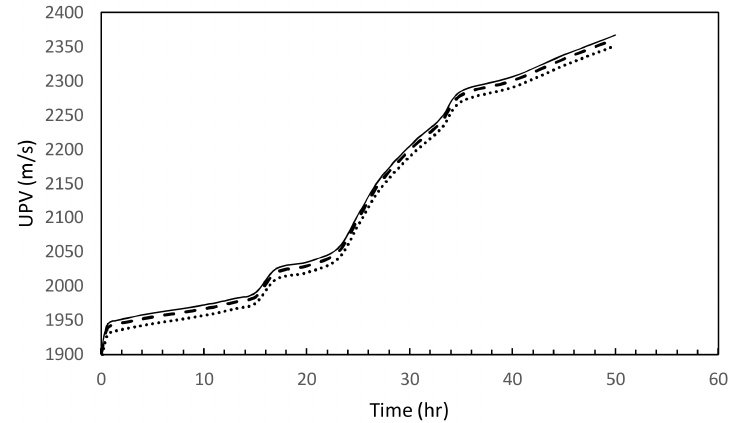
Figure 16. Reproducibility check on three UPV tests for the same mix design (Mix